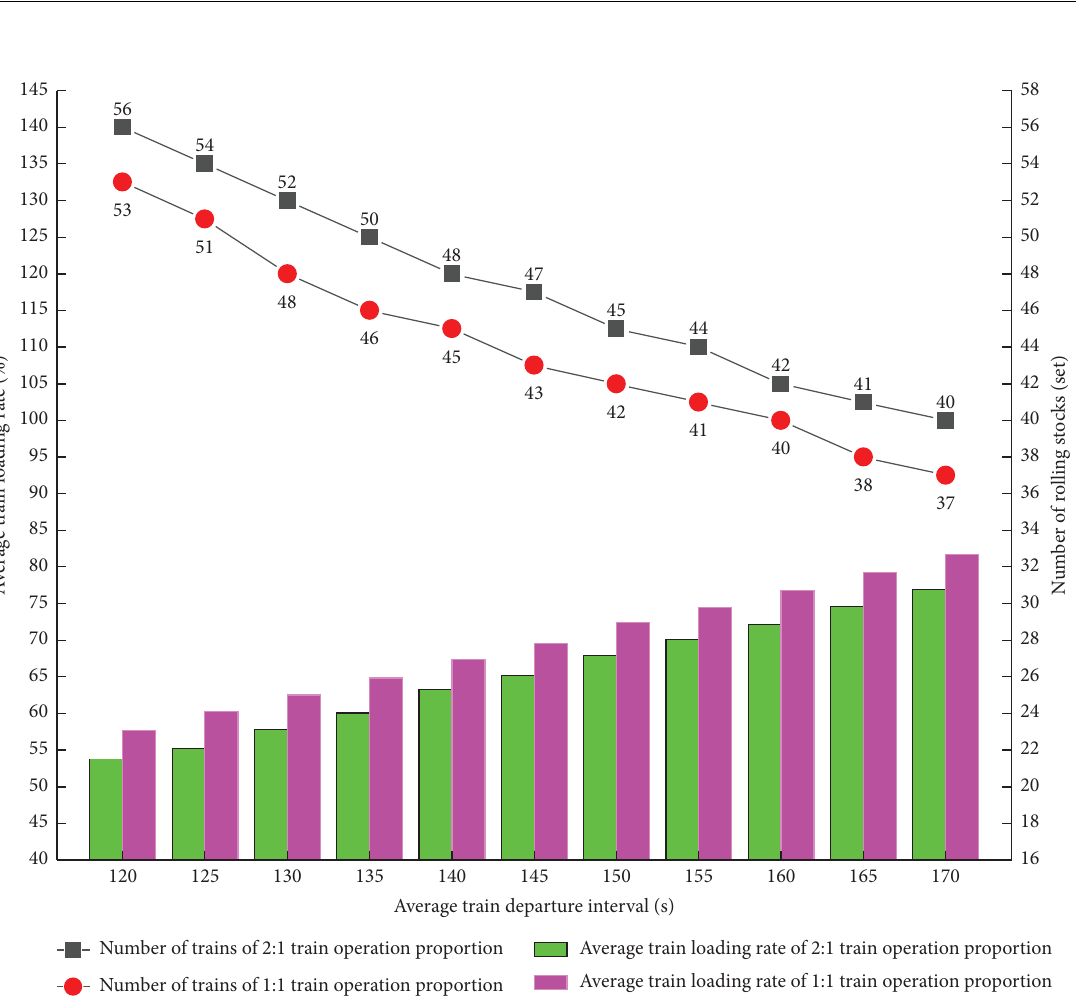
Figure 10: Optimization results for an irregular schedule with diferent train operation proportions.